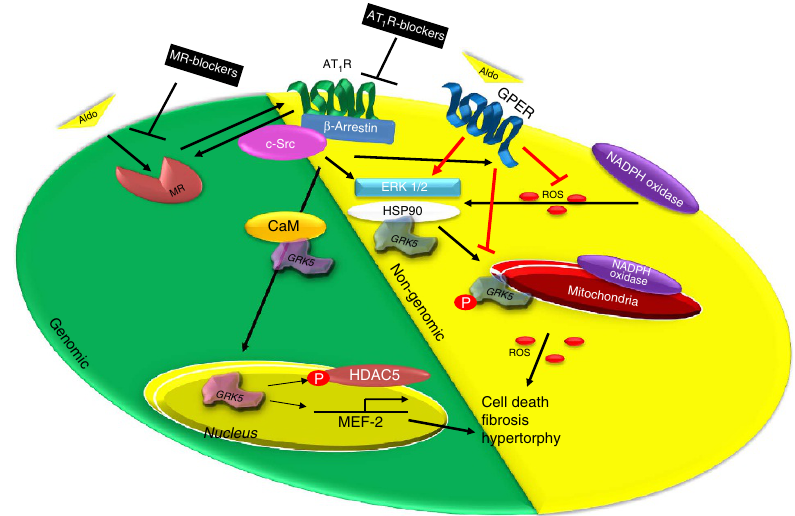
Figure 9 | Schematic representation of aldosterone-dependent activation of GRK2 and GRK5 in NRVMs. Following binding with the MR, aldosterone recruits the b -arrestin/c-Src complex thus inducing the endocytosis of the AT 1 R and then leading to the activation of ‘genomic’ and ‘non-genomic’ pathways. GRK5 is part of genomic pathway since following AT 1 R activation, it binds to the Ca 2 þ -CaM and translocates into the nucleus of the cardiomyocyte. Then, GRK5 acts as a HDAC5 kinase increasing the transcription of hypertrophic genes (that is, MEF2). In contrast, GRK2 is mainly involved in the non-genomic response to aldosterone stimulation. In fact, this kinase following NADPH oxidases and ERK activation is phosphorylated at ser670, and following the binding to the chaperone HSP90, GRK2 translocates to mitochondria, where it increases myocyte apoptosis. Aldosterone through GPER activation activates a parallel signalling that inhibits the phosphorylation of GRK2 and the subsequent ROS generation. Thus, GRK2 and GRK5 participate to ventricular dysfunction and heart failure progression downstream of hyper-aldosteronism. Treatment of cardiomyocytes with MR or AT 1 R antagonists or with b ARKct and also knockdown of GRK2 or GRK5 them self inhibit the MR/AT 1 R signalling